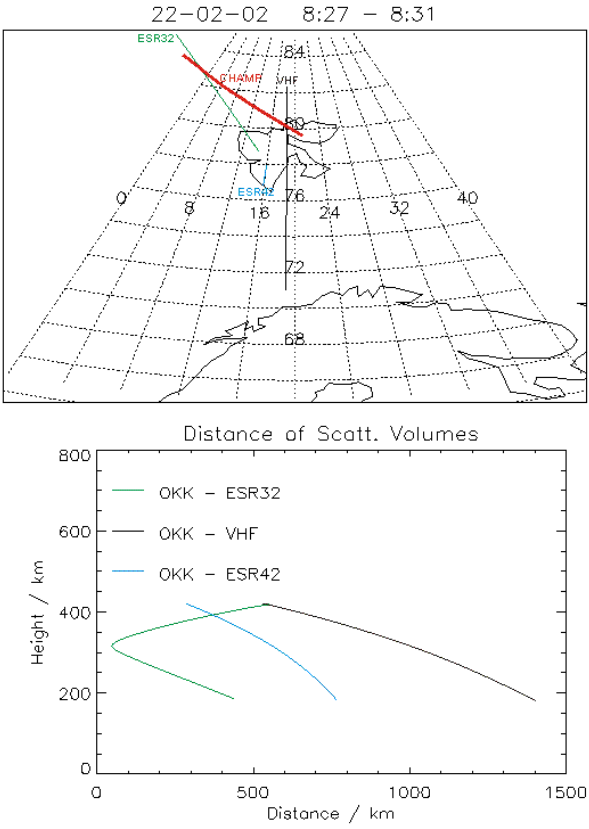
Fig. 8. Same as Fig. 1, but for the event on 22 February 2002.